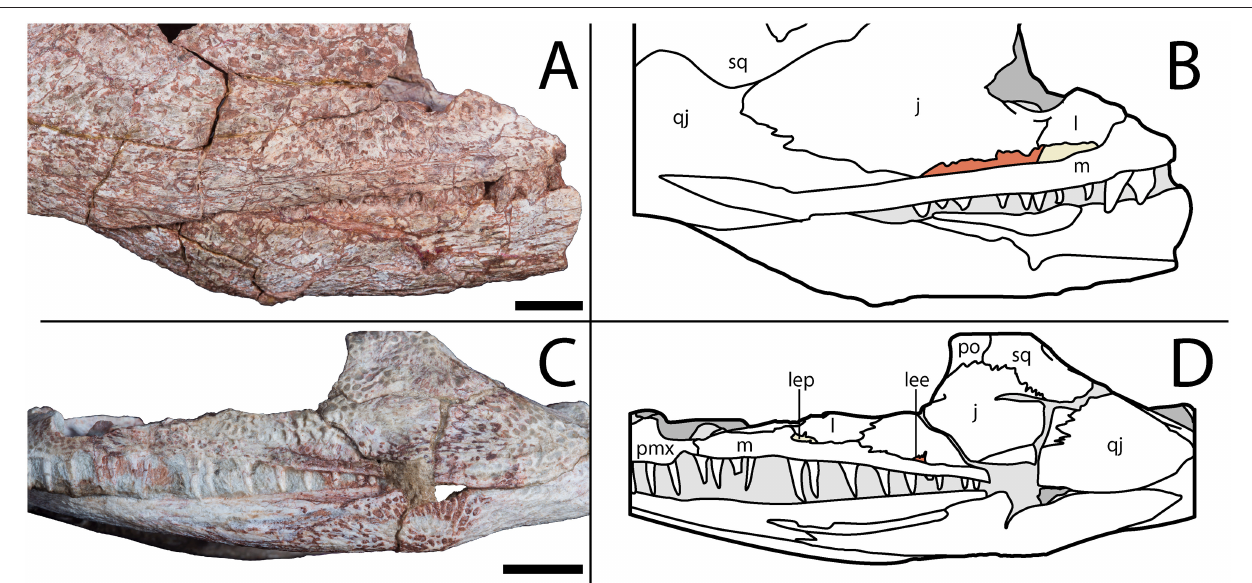
FIGURE 5 | AMNH FARB 4205, holotype of Acheloma cumminsi , in right lateral profile and FMNH UC 1584, holotype of “ Trematops willistoni ,” in left lateral profile. (A) Photograph showing lateral exposures of the palate in AMNH FARB 4205; (B) line drawing of the same; (C) photograph showing lateral exposures of the palate in FMNH UC 1584; (D) line drawing of the same. Lateral exposure of the palatine (beige) and ectopterygoid (red) are shaded following their colors in the digital segmentation of OMNH 79318 (see Figure 7 for isolated palate). Scale bars equal to